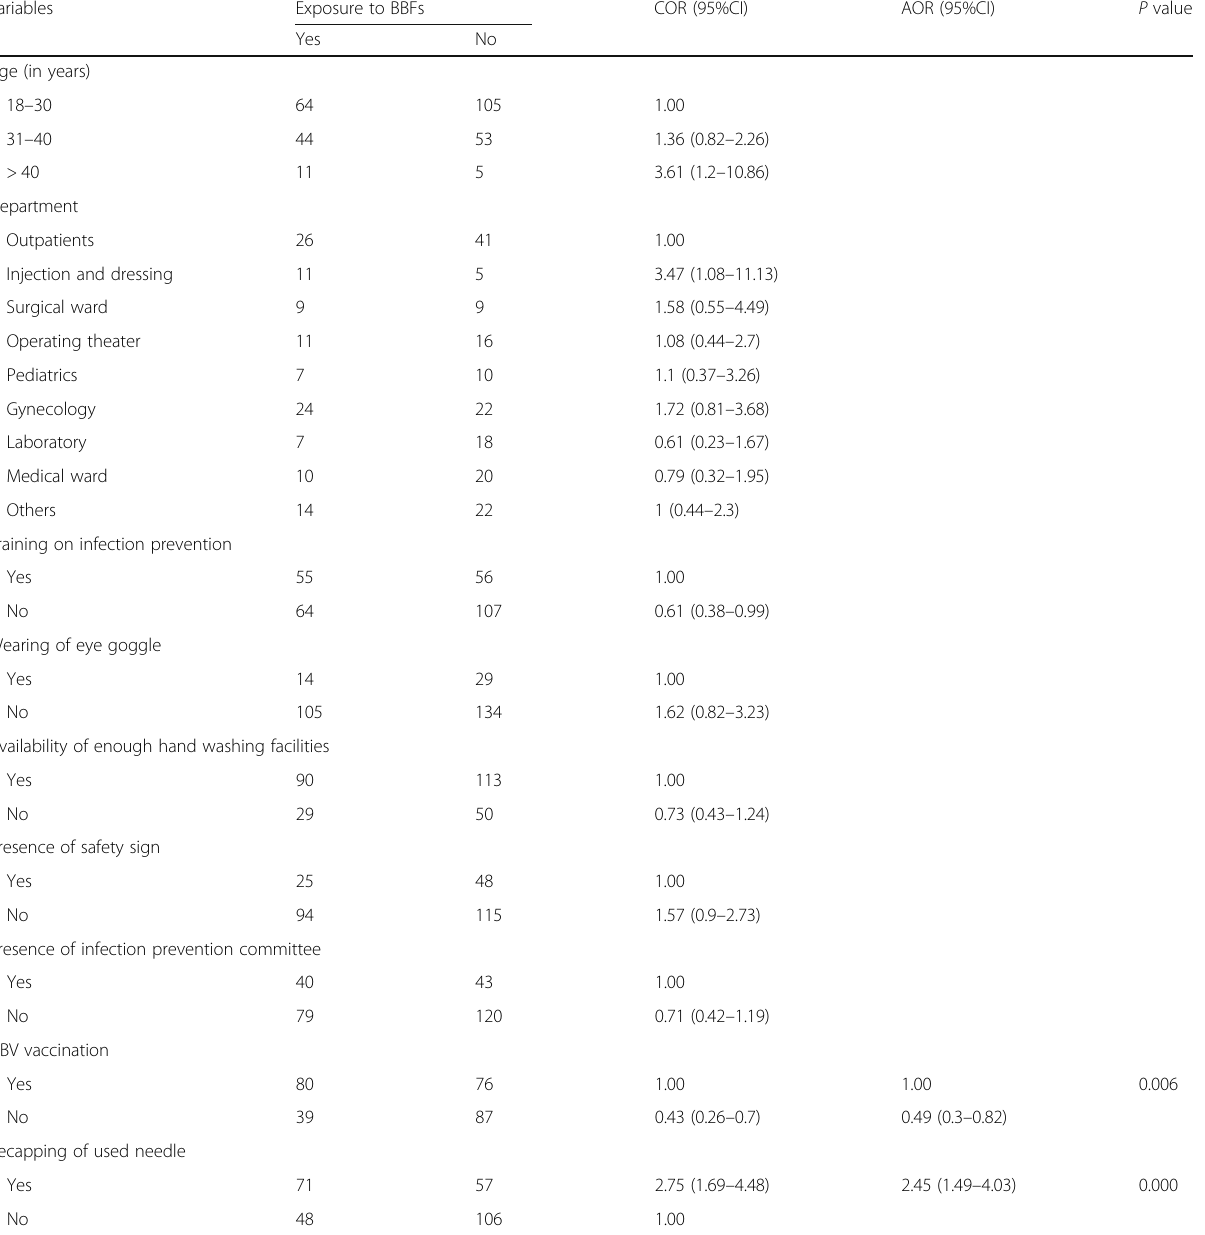
Table 5 Multivariate logistic regression analysis of risk factors associated with NSI in the past year exposure to blood and body fluids Variables Exposure to